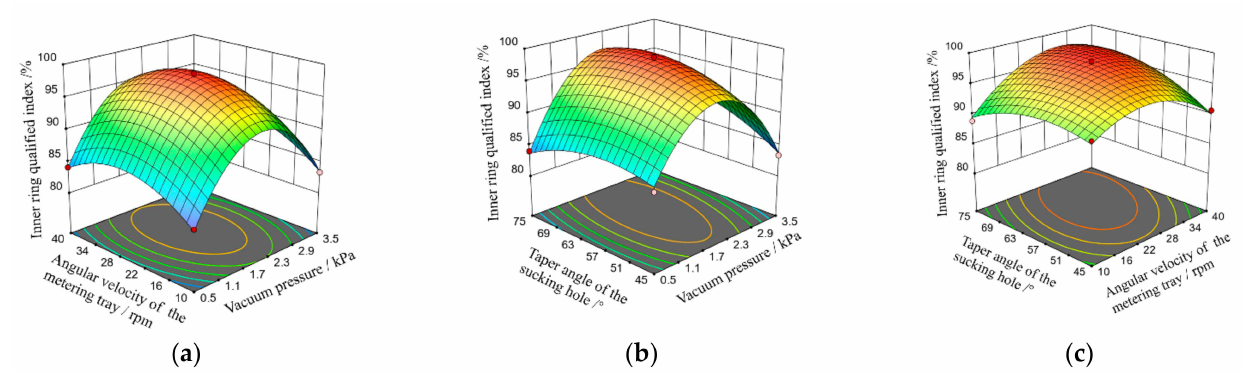
Figure 5. Effect of ( a ) angular velocity of metering tray and vacuum pressure, ( b ) taper angle of sucking hole and vacuum pressure, and ( c ) taper angle of sucking hole and angular velocity of metering tray on the inner ring qualified index.